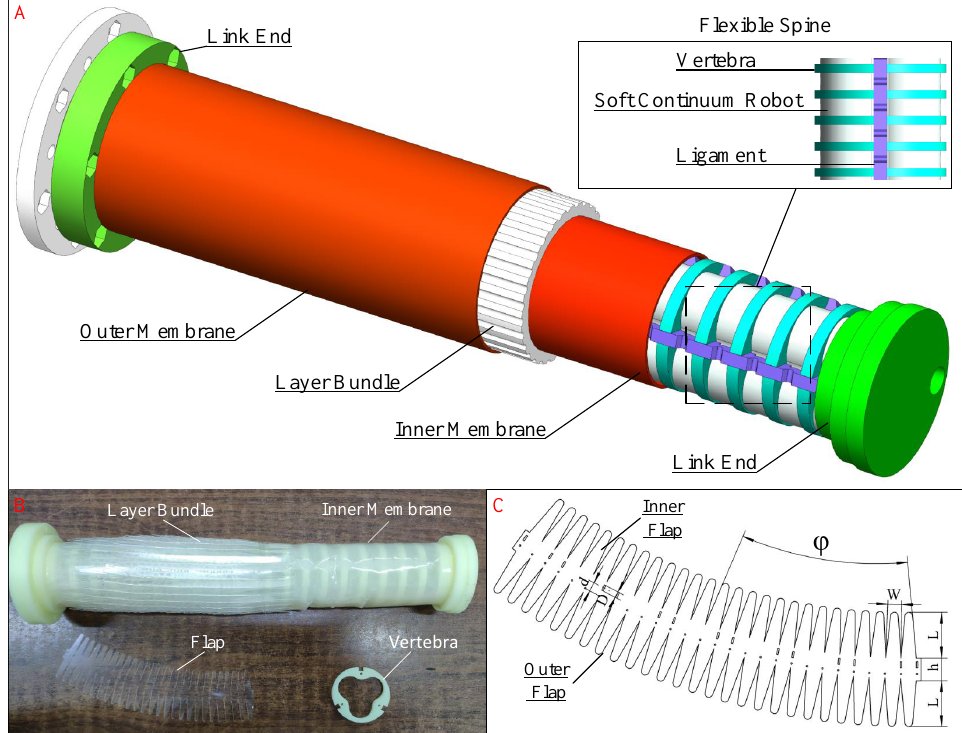
Figure 1. ( A ) Sectional view of a pneumatic-actuated TSCR. ( B ) Structure of TSCR prototype. ( C ) Flap pattern used for stiffening segment based on layer